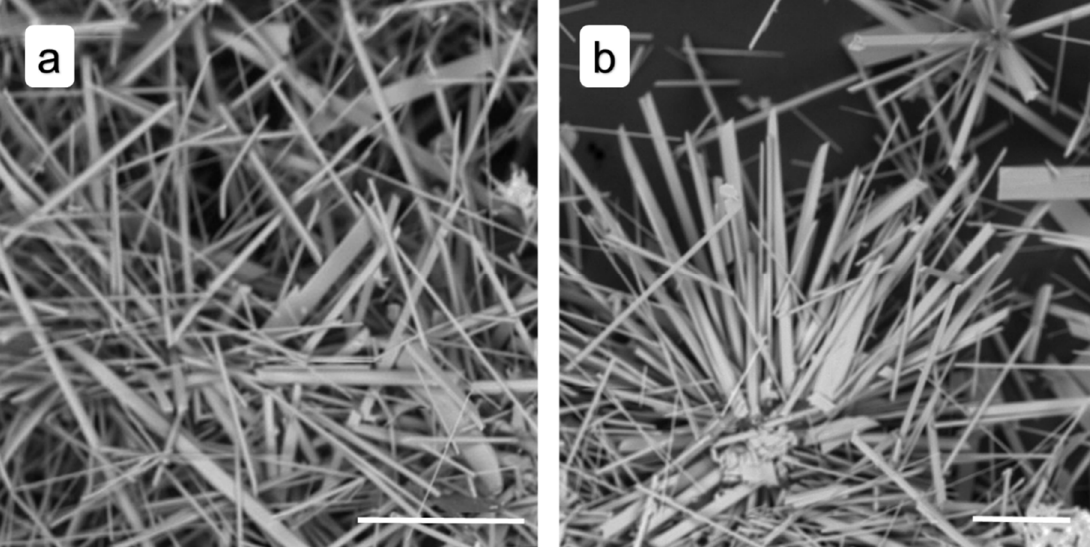
Figure 4. SEM images of gypsum crystals isolated from ( a ) (nonfiltered) and ( b ) (filtered) gypsum solutions 24 h after sulfate and calcium brines get mixed. Scale marker corresponds to 100 μ m.